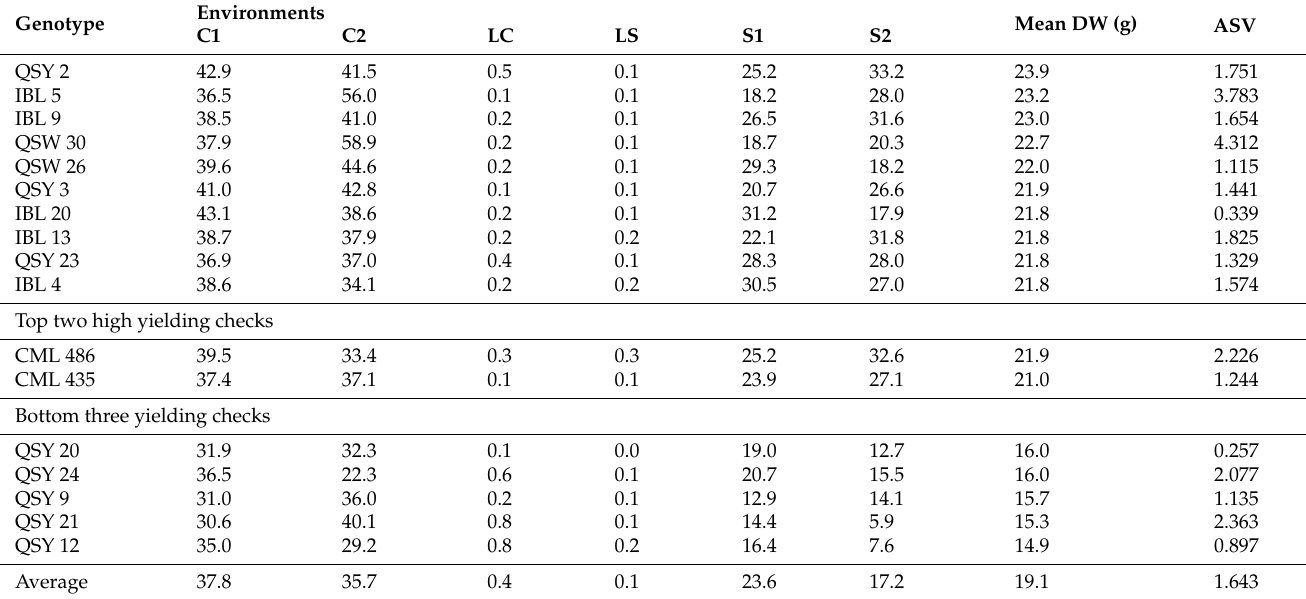
Table 3. Means and ASV of the top ten and bottom five yielding genotypes across the six environments. The genotypes are ranked according to mean dry weight (DW).